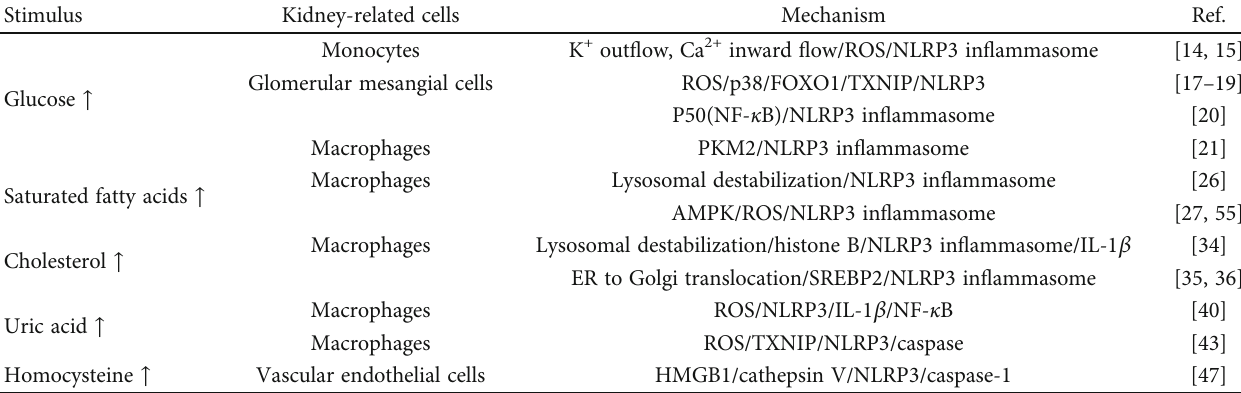
Table 1: Aberrant metabolites activate the NLRP3 in fl ammasome in kidney-associated cells.